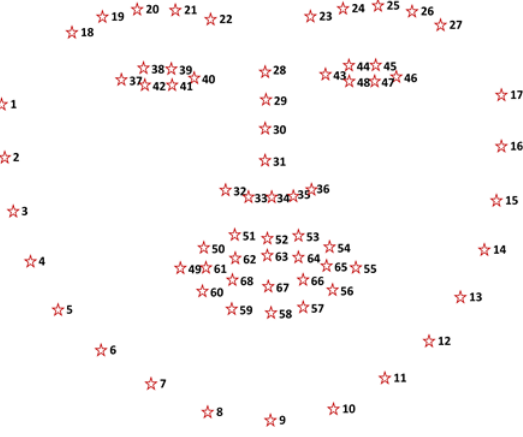
Figure 2 . A total of 68 landmark positions on a